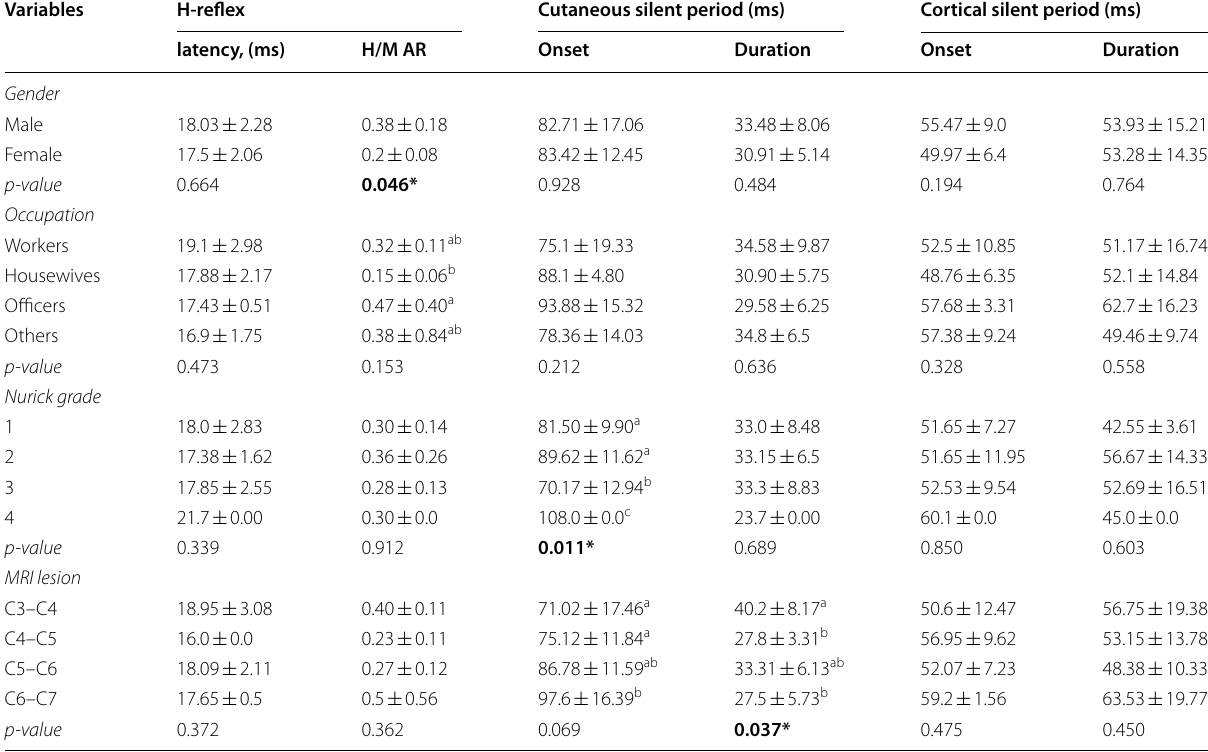
Different small letters indicate significant differences, *Statistically significant at AR amplitude ratio